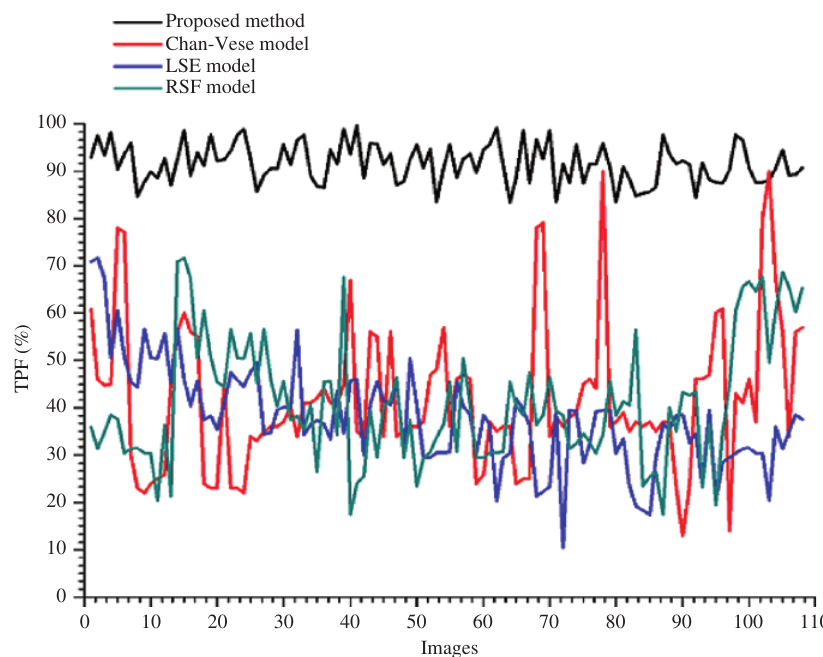
Figure 8: Comparison of Performance Evaluation Results using